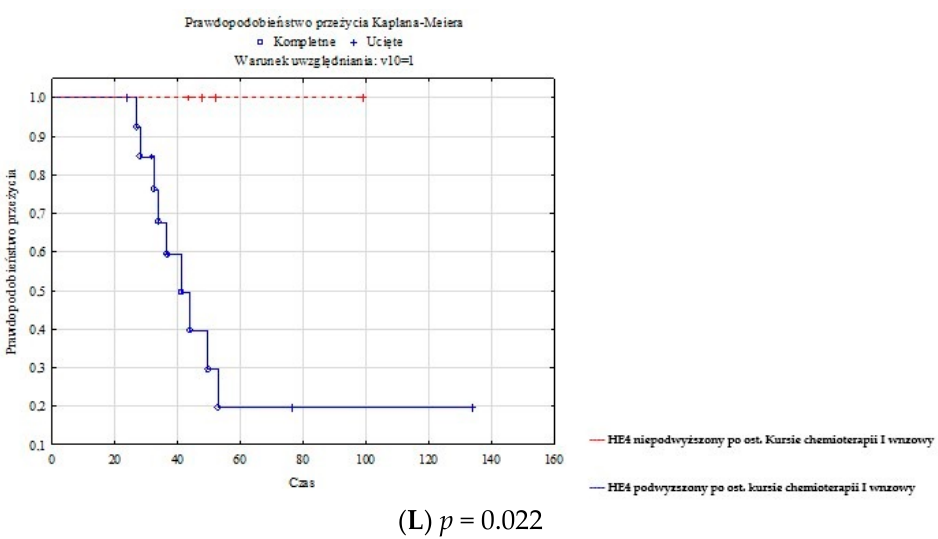
Figure A1. Kaplan–Meier survival curves for overall survival (OS) according to HE4 concentration.